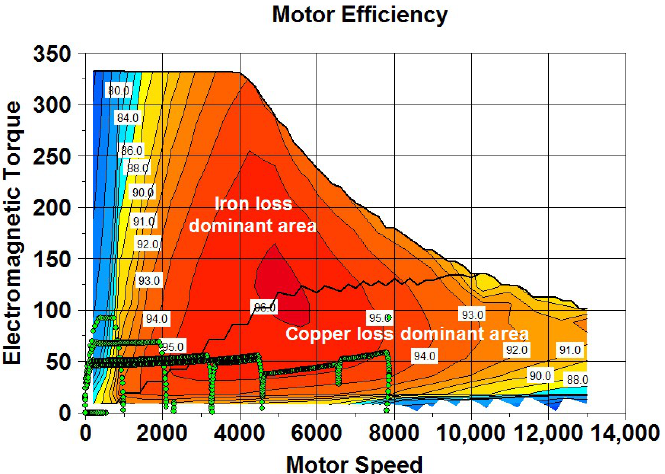
Figure 5. Relationship between iron loss, copper loss, and efficiency distribution of motor.